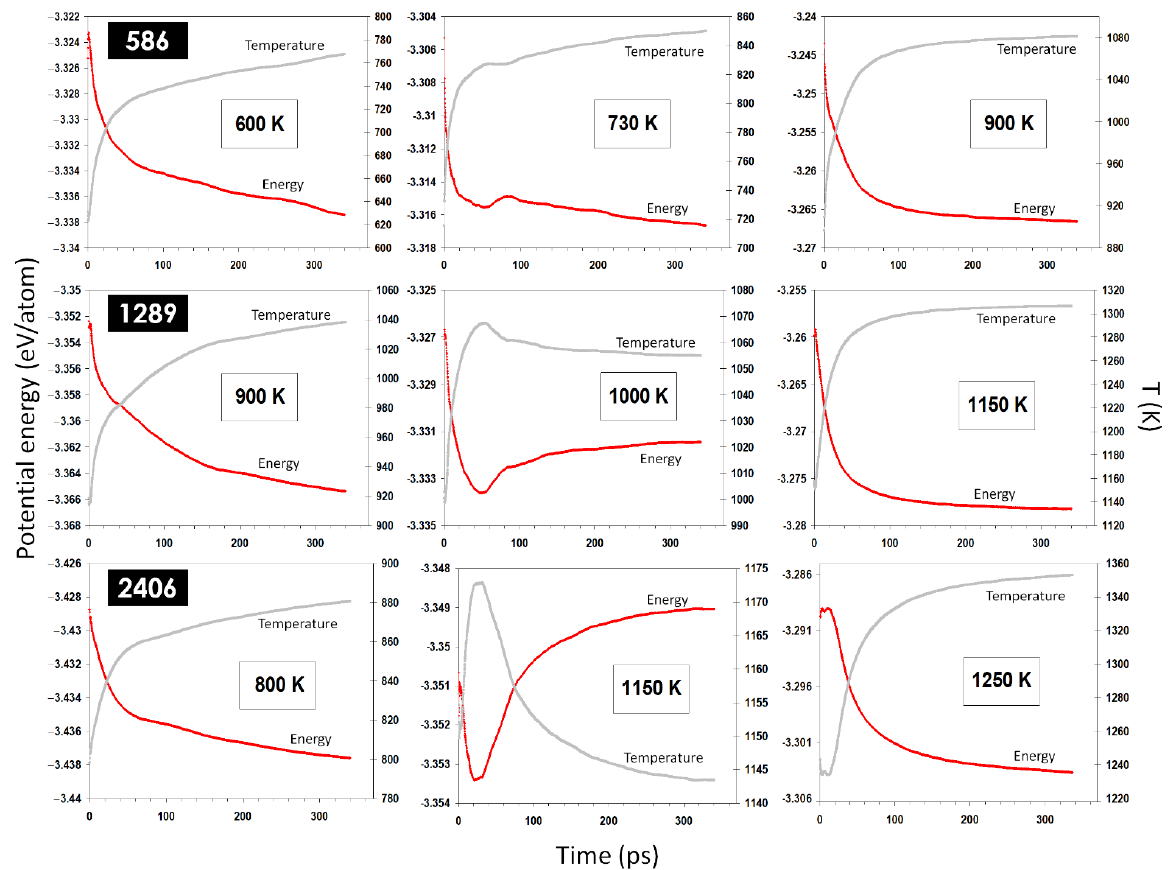
Figure 7. Potential energy and temperature evolution in coalescing nanoparticles of different sizes and at different temperatures. A sudden change in the energy/temperature curves was observed only for temperatures close to the corresponding melting points of the nanoparticles, indicating a surface-induced melting of the nominally solid nanoparticles.